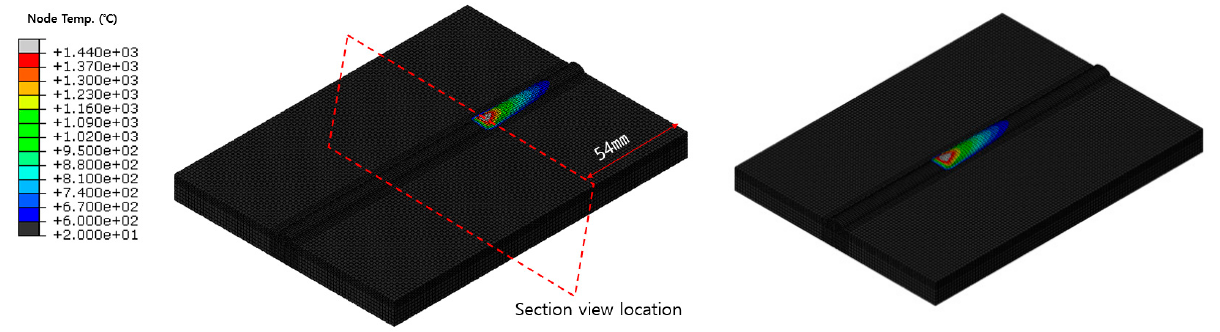
Figure 12. Iso view and section check position in the heat transfer analysis for the original dimension model.